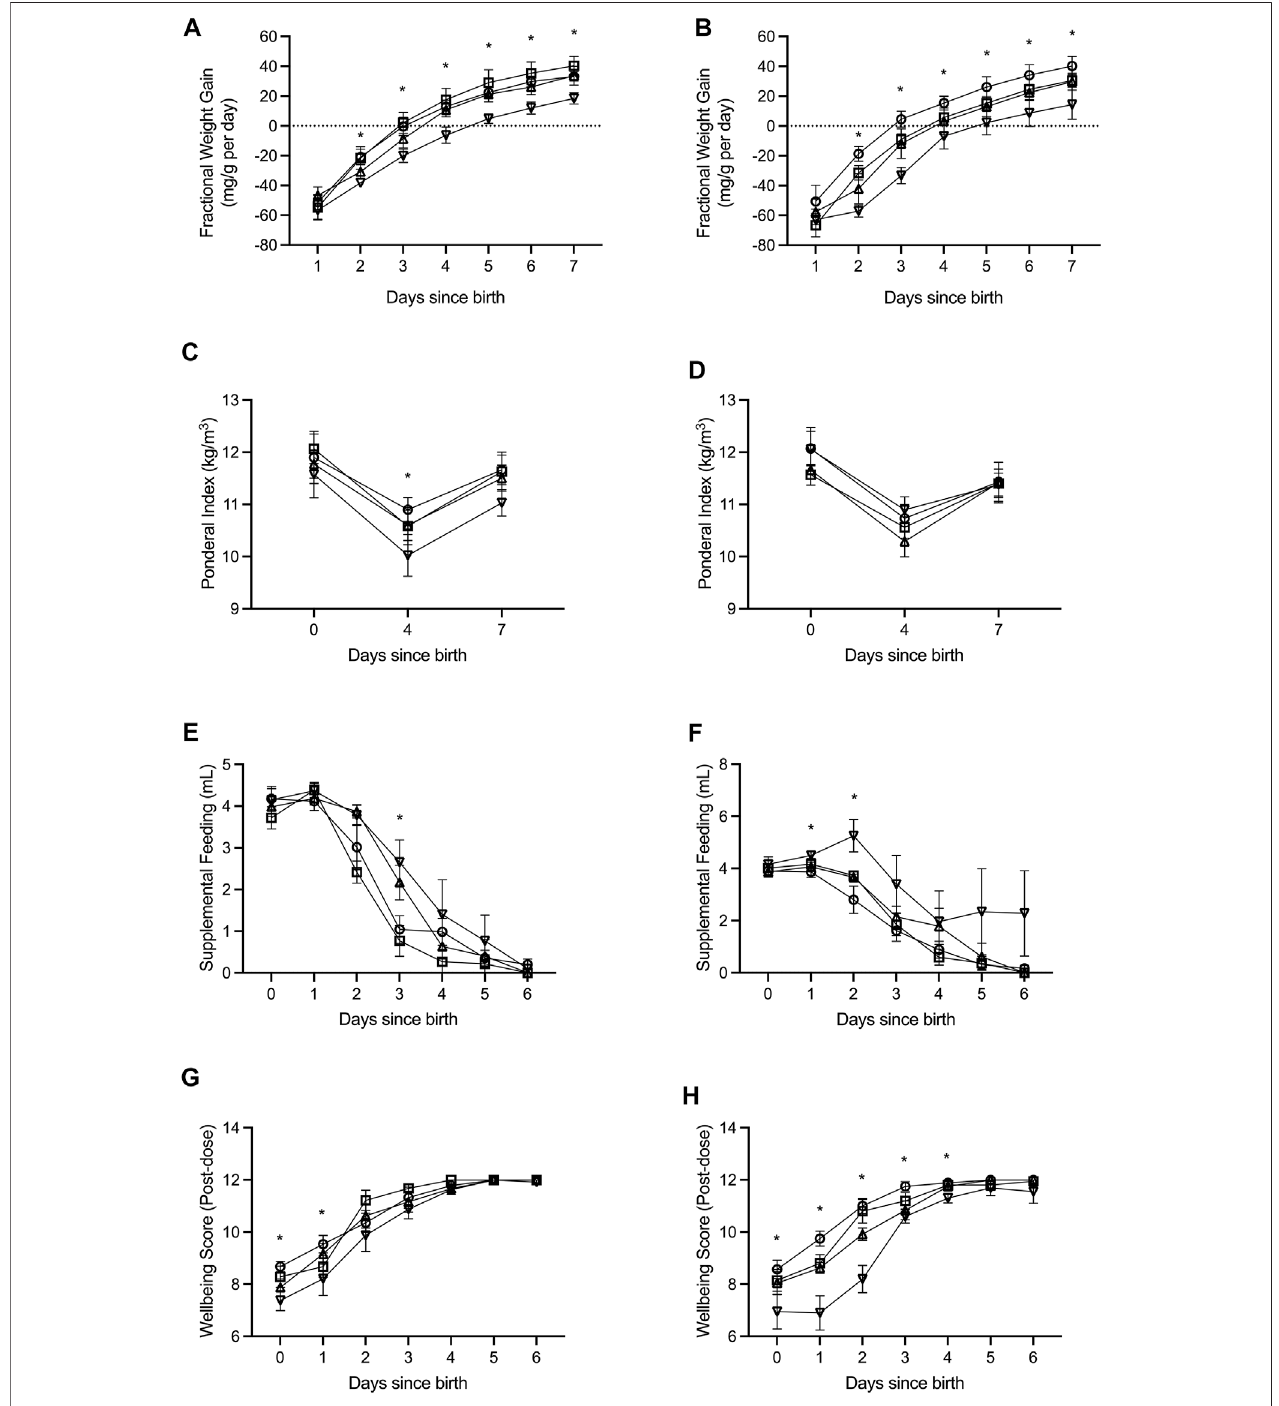
FIGURE1 | Fractional weight gain (A,B) , ponderalindex (C,D) , supplemental feeding (E,F) , and wellbeing score (G,H) wasrecorded from birth (dayssincebirth0) until term equivalence (postnatal age 7) for male (A,C,E,G) and female (B,D,F,H) preterm neonates receiving high-GNX (downward facing triangle; males n = 6, females n = 5), mid-GNX (upward facing triangle; males n = 6, females n = 6), and low-GNX (square; males n = 6, females n = 6) and compared to control (circle; males n = 7, females n = 7) preterm neonates. Data presented as means ± SEM with * indicating signi fi cance at p < 0.05.